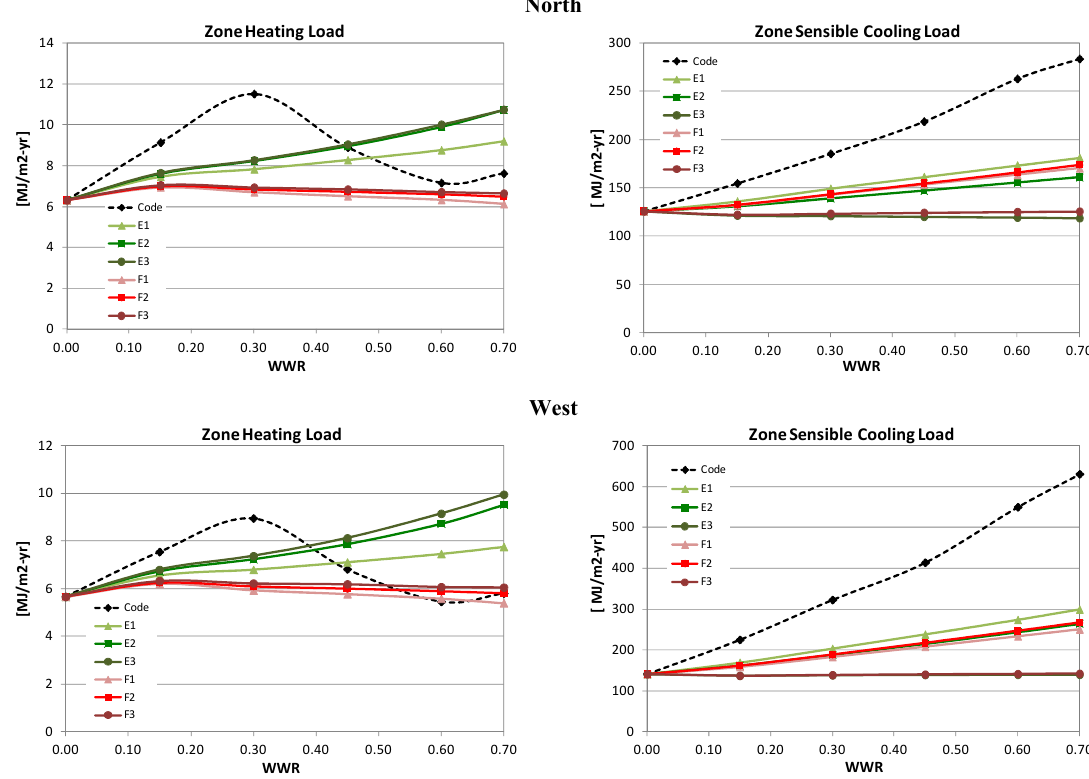
Figure 2. Heating and sensible cooling loads (MJ/m 2 -year) for perimeter zones in